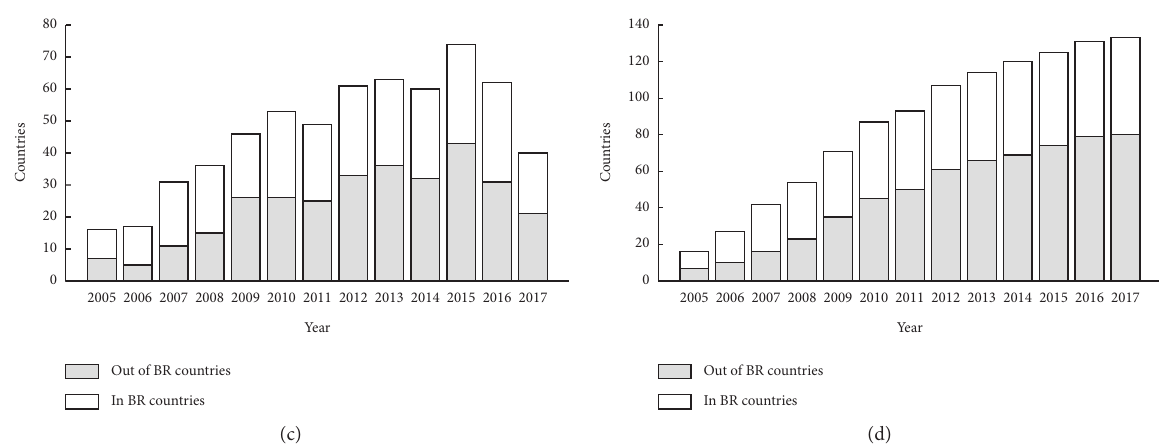
Figure 16: China’s overseas construction projects in or out of BR (No. 5): (a) annual millions; (b) accumulated millions; (c) annual countries; (d) accumulated countries.